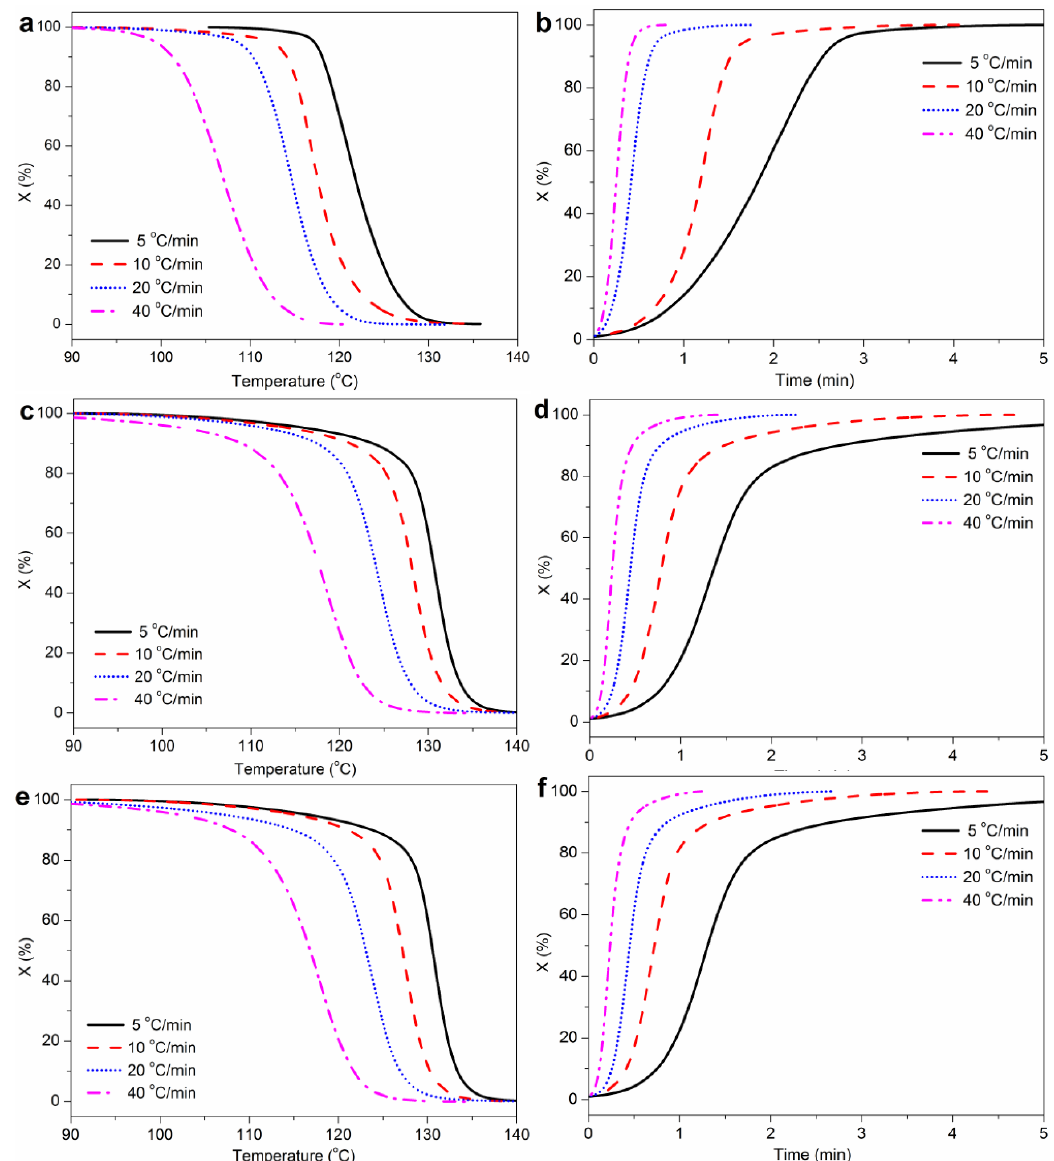
Figure 7. Relative crystallinity (X) as a function of temperature or time for non-isothermal crystallization of ( a , b ) WF/PP, ( c , d ) WF/PP-TMB 0.3 and ( e , f ) WF/PP-WBG 0.3 .